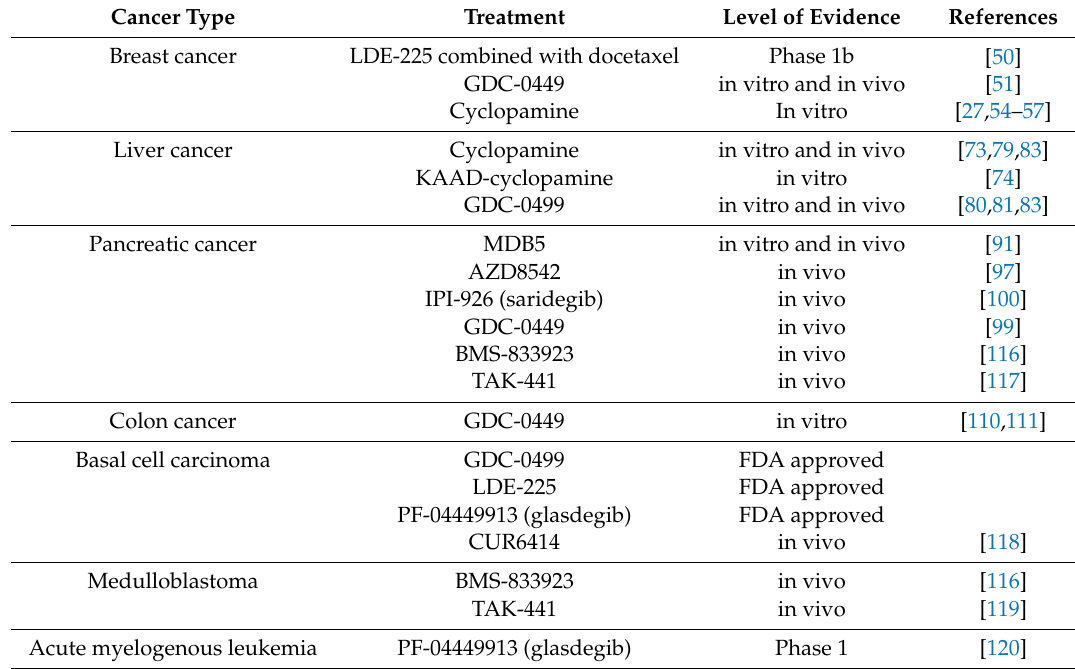
Table 1. Hedgehog / Smo drugs in di ff erent cancer